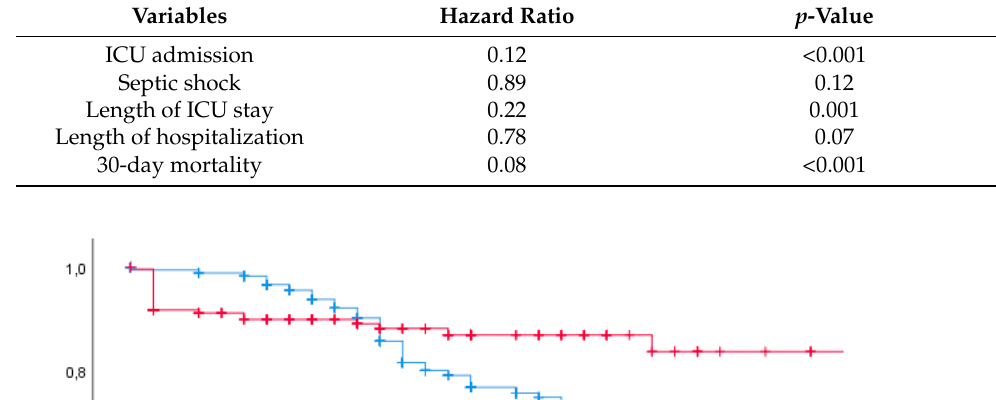
Table 4. Association between early effective antibiotic therapy and outcomes in all study patients.